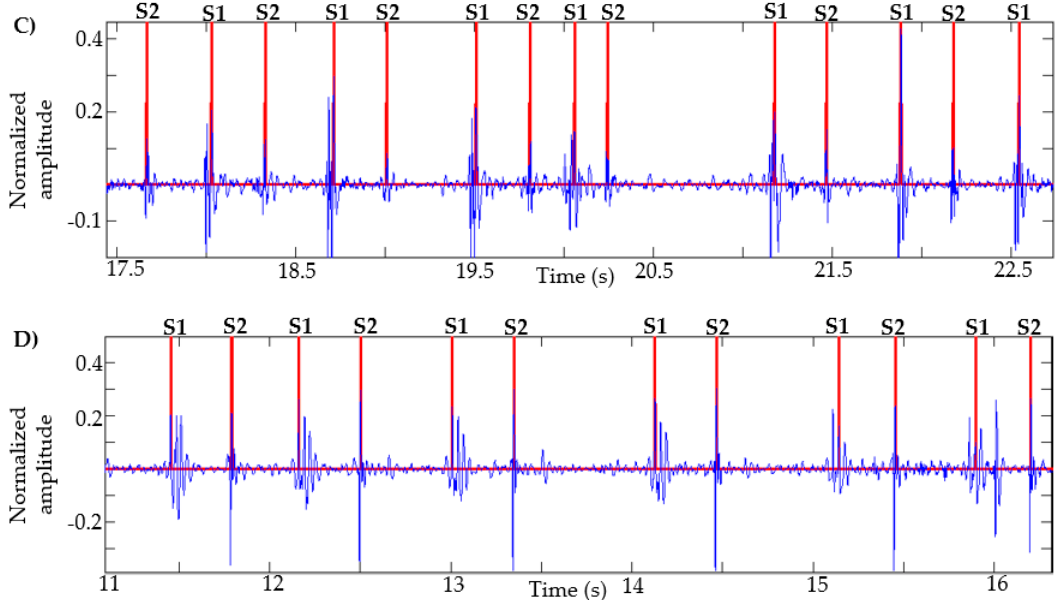
Figure 7. Examples of segmentation using the proposed method. Heart sound signals for recordings ( A ) a031, ( B ) a0112, ( C ) a0284 and ( D ) a0352 are taken from the PhysioNet/CinC Challenge 2016, together with the successful segmentations using the proposed